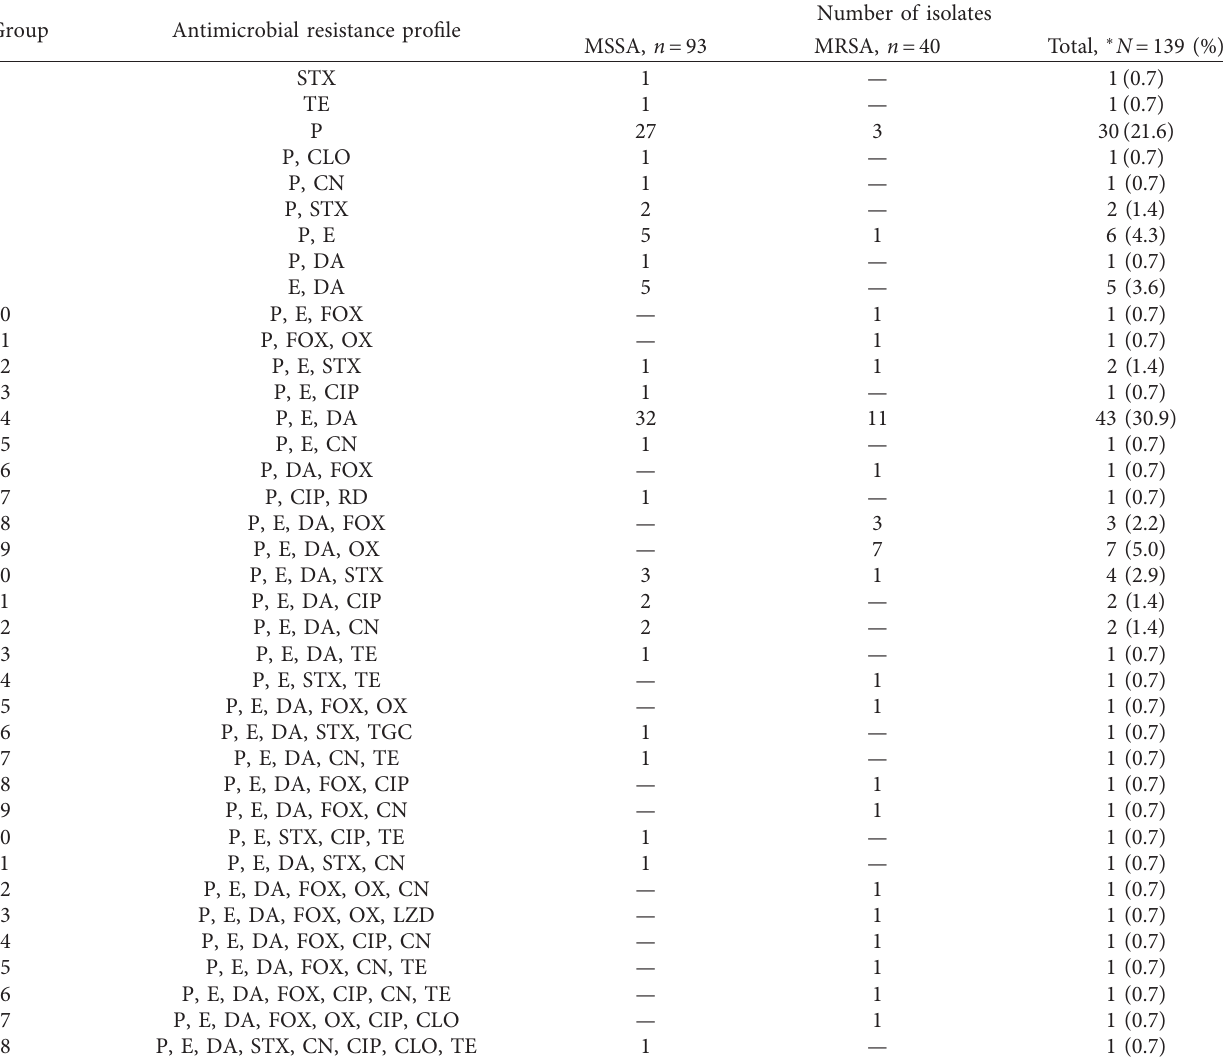
Table 4: Distribution of antimicrobial resistance profiles of methicillin-susceptible and methicillin-resistant Staphylococcus aureus isolated from the anterior nares of healthcare workers and students attending the University Hospital of Londrina in southern Brazil. Group Antimicrobial resistance